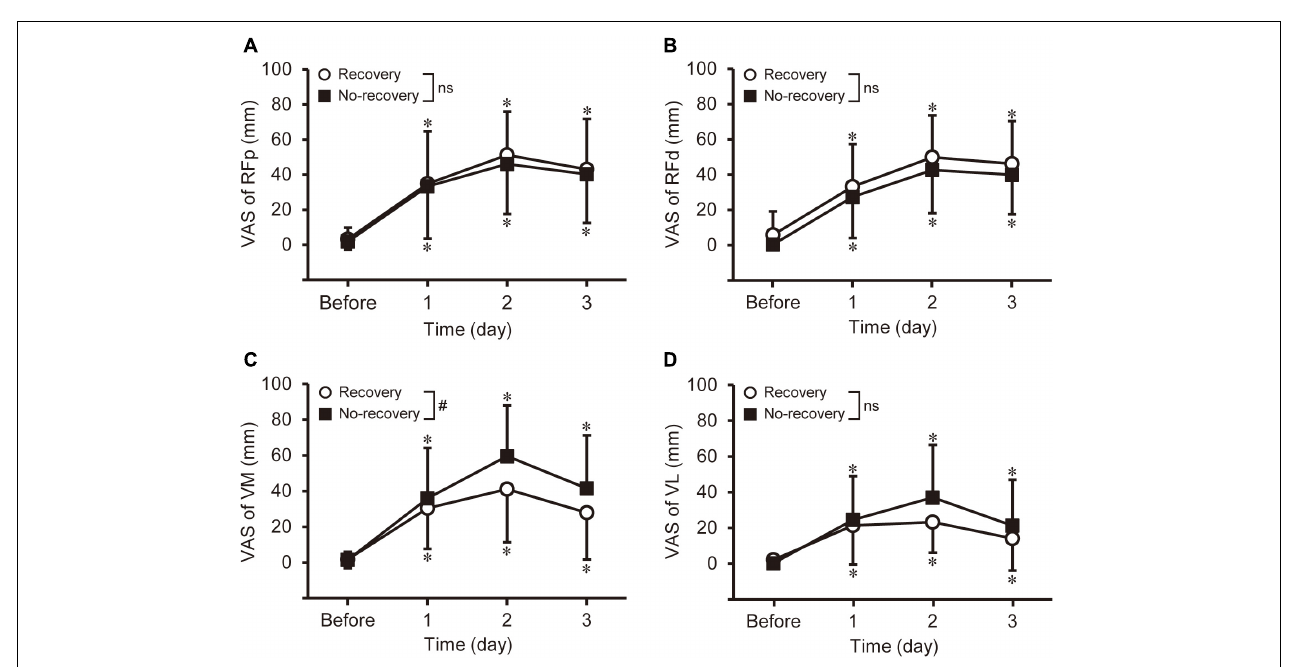
FIGURE 1 | Changes (mean ± SD) in maximal voluntary isometric contraction (MVIC) torque (A) , potentiated doublet torque (B) , and voluntary activation (VA) during the MVIC (C) before, immediately after (0), and 1–3 days after eccentric exercise for the recovery and no-recovery groups. * Indicates a significant difference from baseline. † Shows a significant difference between groups. # Demonstrates a significant interaction effect. ns shows no significant interaction effect.